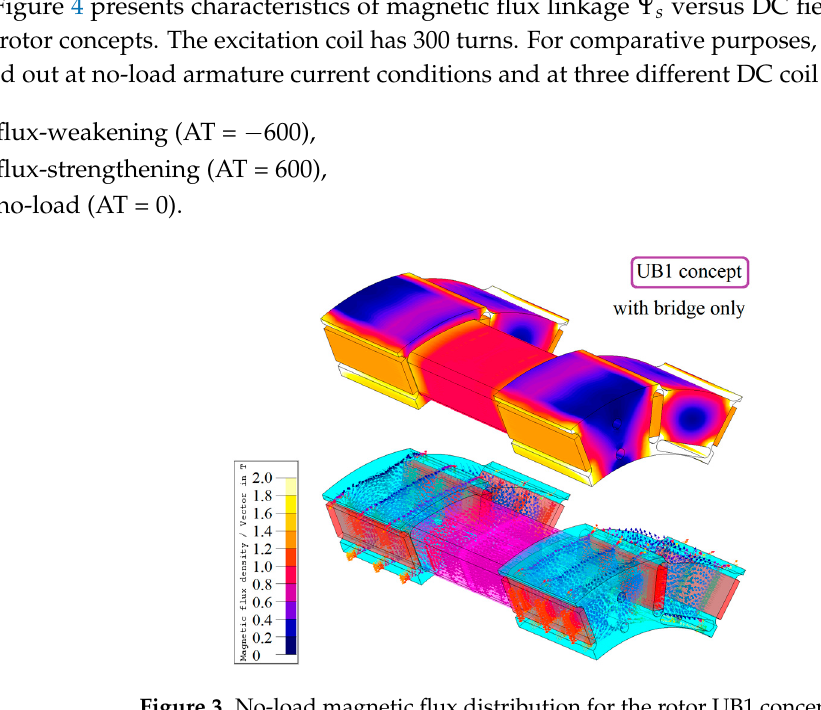
Figure 3. No-load magnetic flux distribution for the rotor UB1 concept.